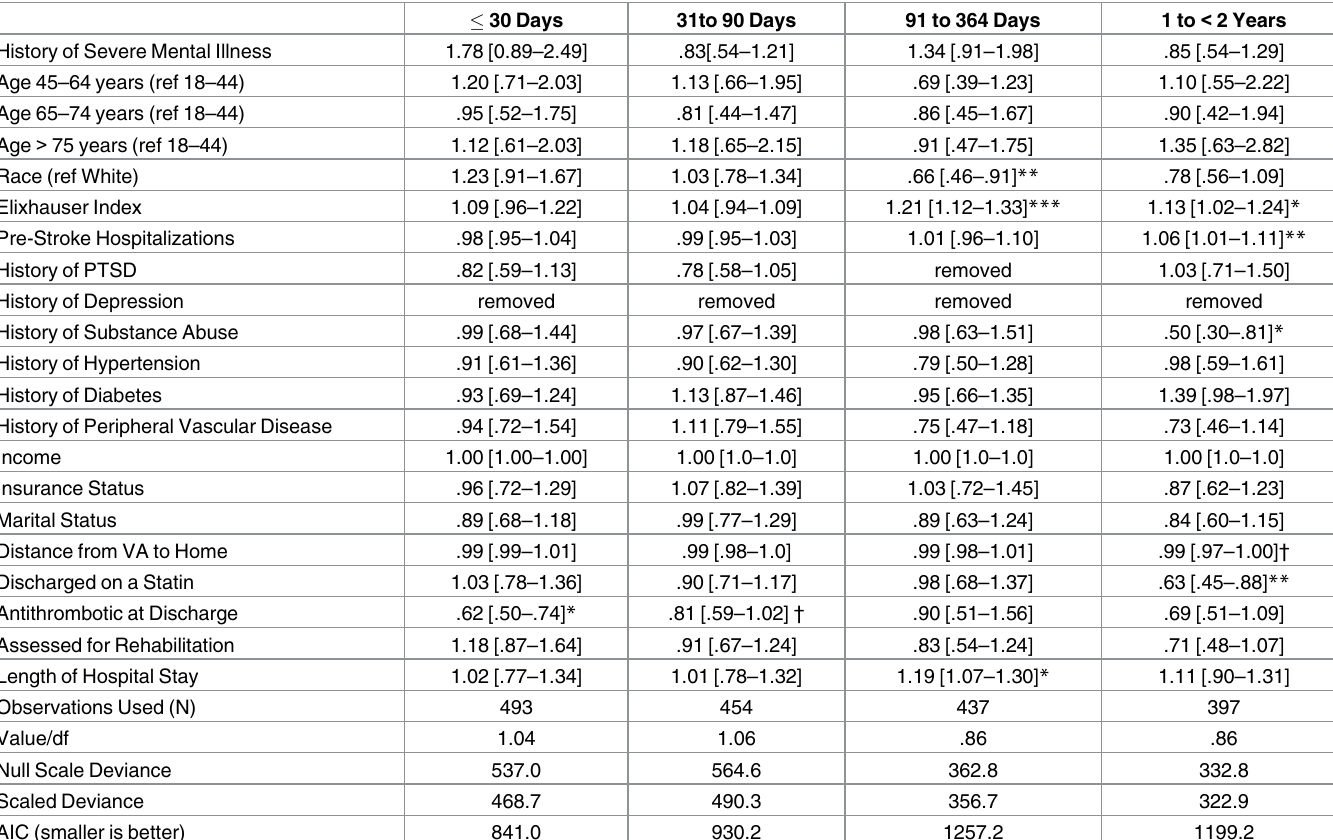
Table 4. Poisson multiple regression assessingthe association of SMI with non-psychiatric hospitalization over time-intervals from (cid:20) 30 Days through